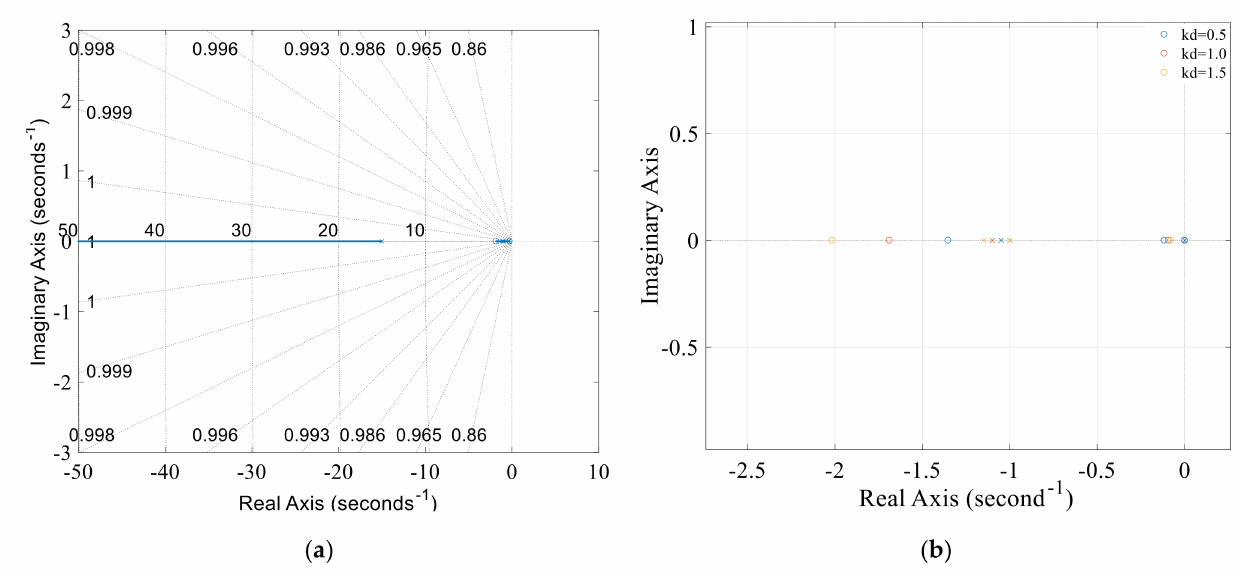
Figure 18. Root-locus response to the variation of the differential adjustment coefficient, k d = [0.5, 1.5]. ( a ) Root-locus response at k p = 1.6, k i = 0.75 and k d = 1, and ( b ) Root-locus response with the variation of k d = 0.5, 1 and